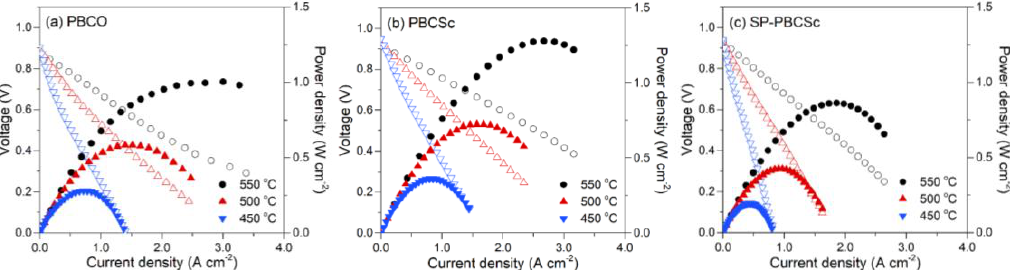
Figure 6. I–V and corresponding power density curves of single cells (Cathode/GDC/Ni-GDC) in a temperature range of 450 to 550 °C: ( a ) PBCO, ( b ) PBCSc, and ( c ) SP-PBCSc, respectively.